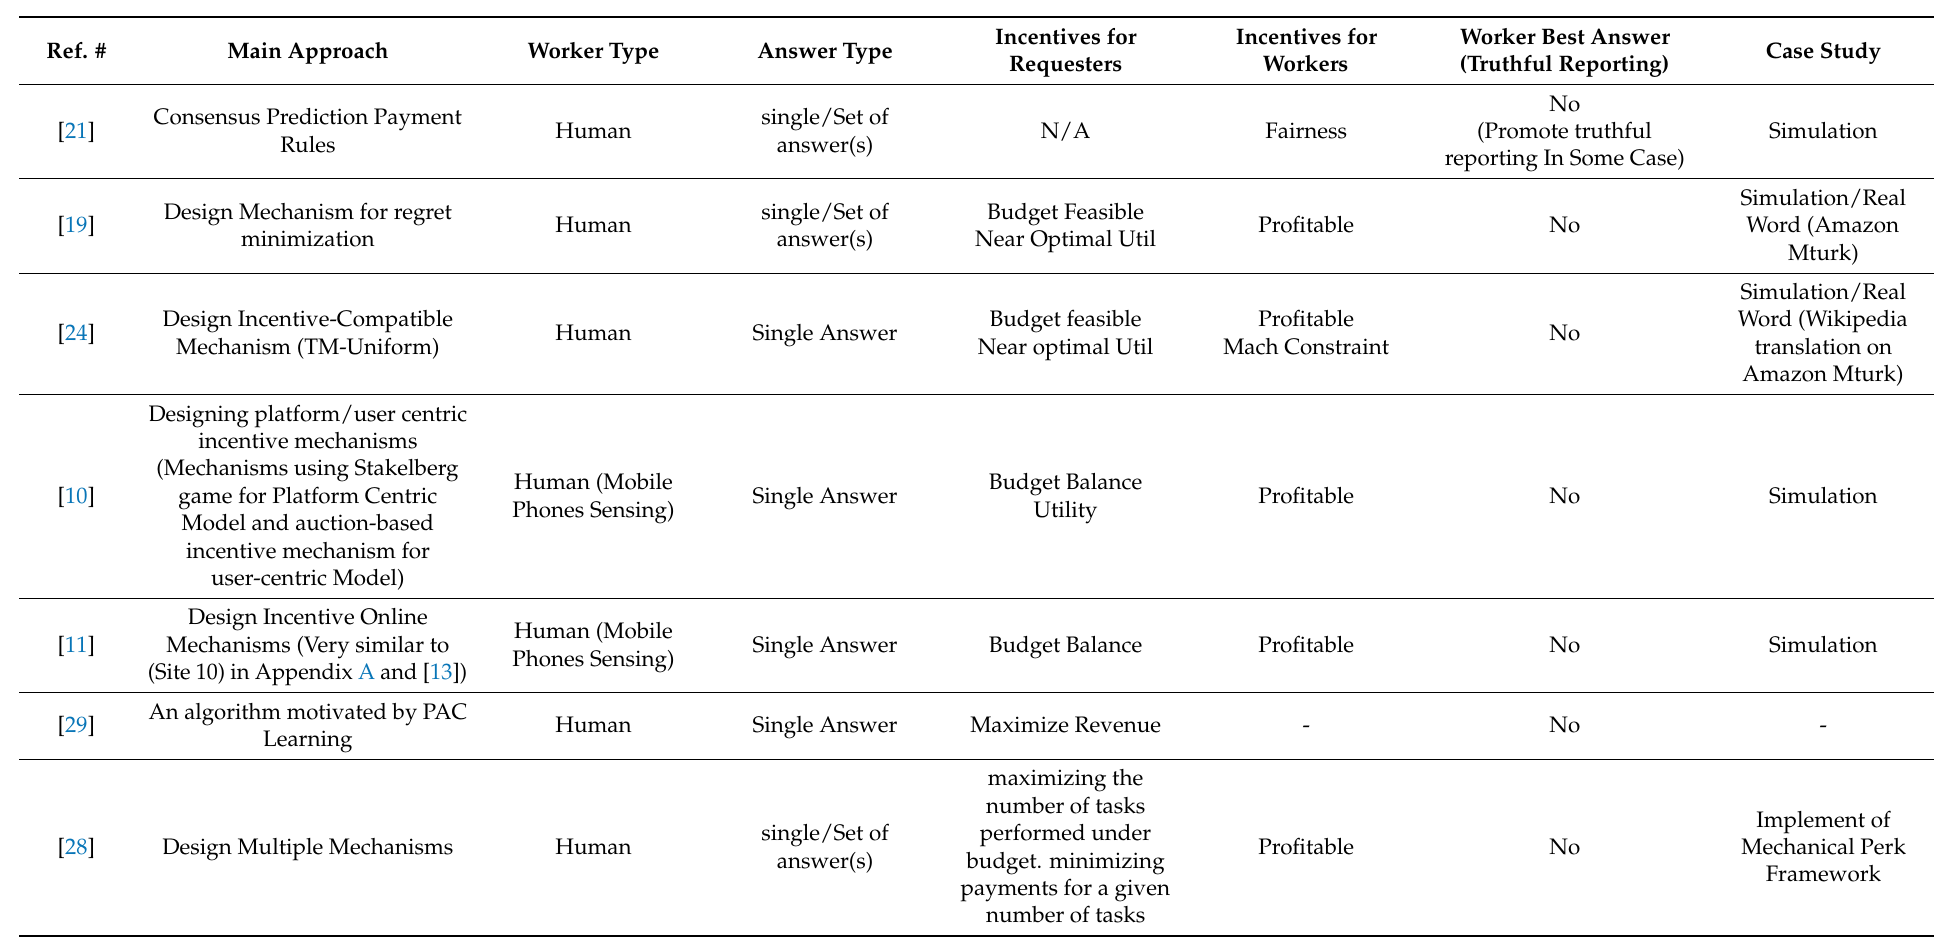
Table 1. Previous research and